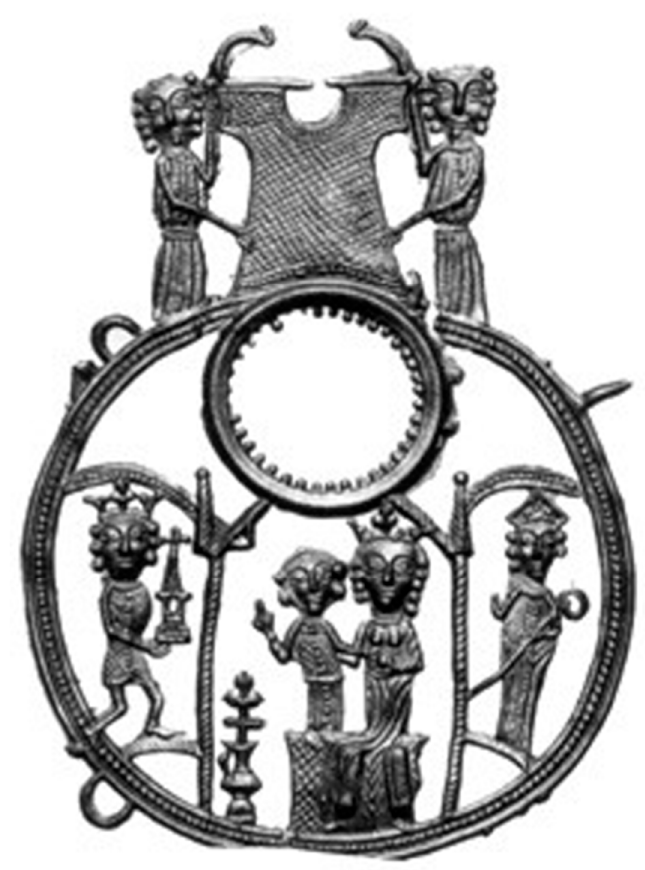
Figure 13. Pilgrim badge with mirror frame, Aachen, 1350–1400. Cothen, H.J.E. van Beuningen